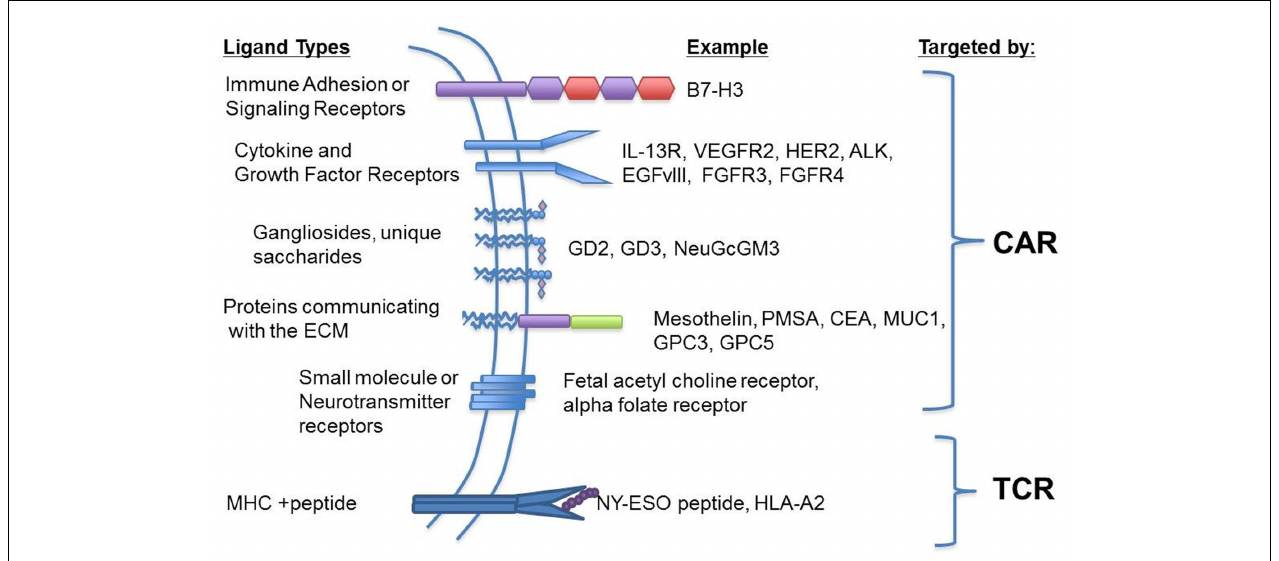
extracellular moiety such as signaling or cytokine receptors, cell adhesion molecules, gangliosides, or other proteins communicating with the extracellular matrix. In contrast, the classicT cell receptor recognizes processed peptides in the context of MHC providing a strategy for targeting intracellular, immunogenic